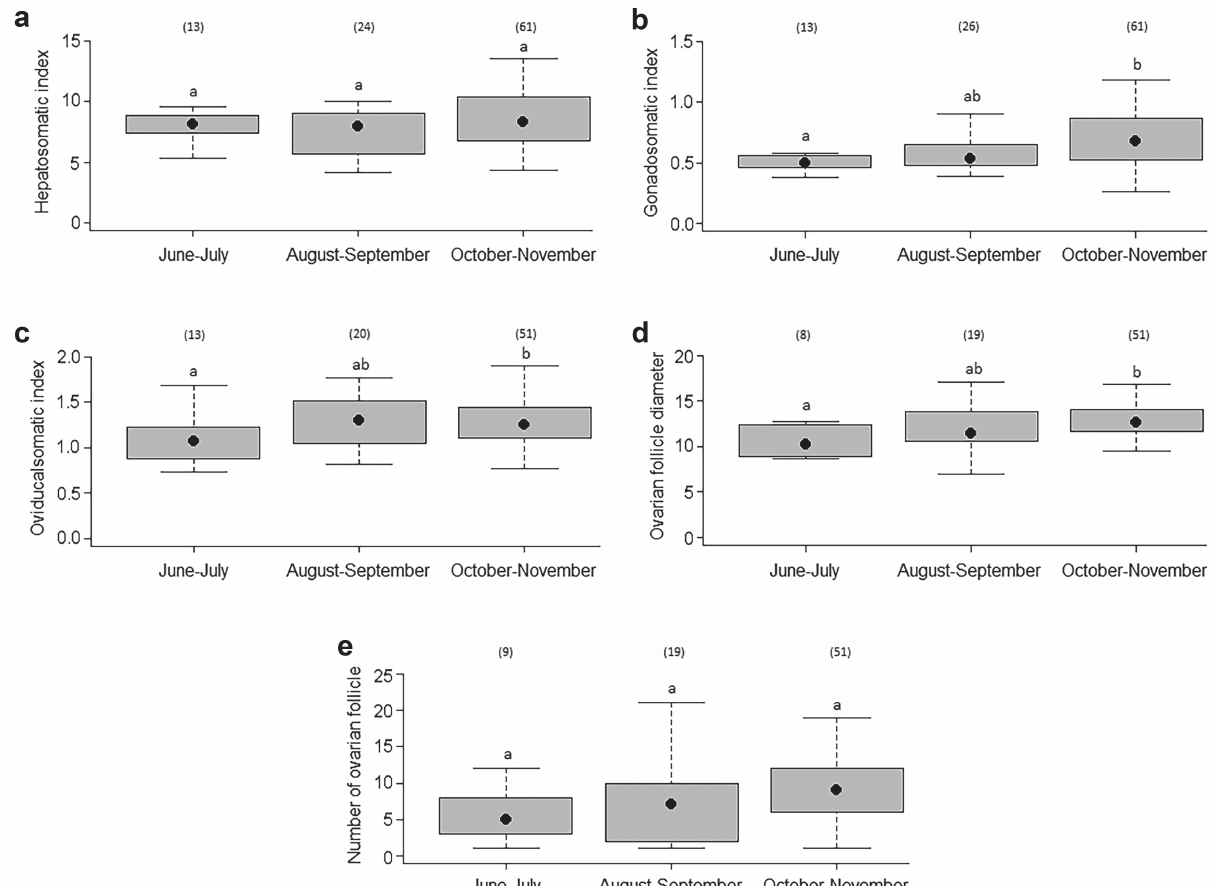
Fig. 7 . Bimonthly variation in a. hepatosomatic index, b. gonadosomatic index, c. oviducalsomatic index, d. diameter of ovarian follicles, and e. number of ovarian follicles in Callorhinchus callorynchus females. The box represents all observed values between the 25th and 75th quartiles, and contains the median (black circles) for each category. The box plot whiskers represent the minimum and maximum observations for each category in this study. Numbers in parentheses represent the sample size for each period and distributions with the same letter are not significantly different (p >